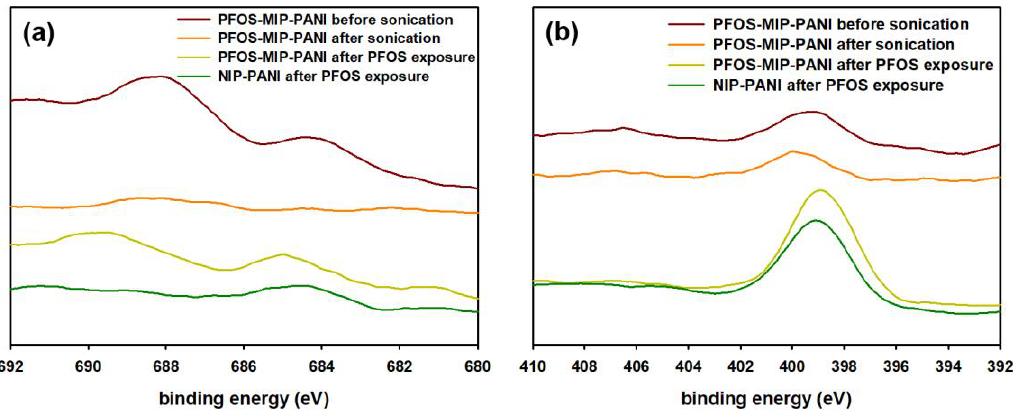
Figure3. XPSspectraofthesurfaceofPFOS-MIP-PANIandNIP-PANI.( a )F1sbonding. ( b )N1sbonding. Figure 3. XPS spectra of the surface of PFOS-MIP-PANI and NIP-PANI. ( a ) F1s bonding. ( b ) N1s bonding.